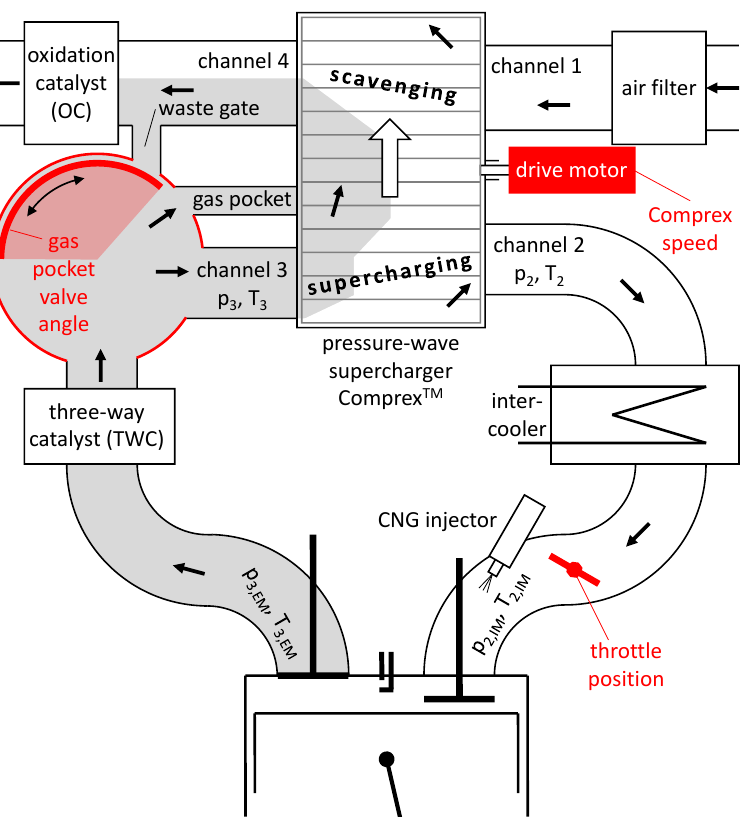
Figure 2. Schematic of the Comprex pressure wave supercharger. The description of the relevant pressures and temperatures is also indicated in the